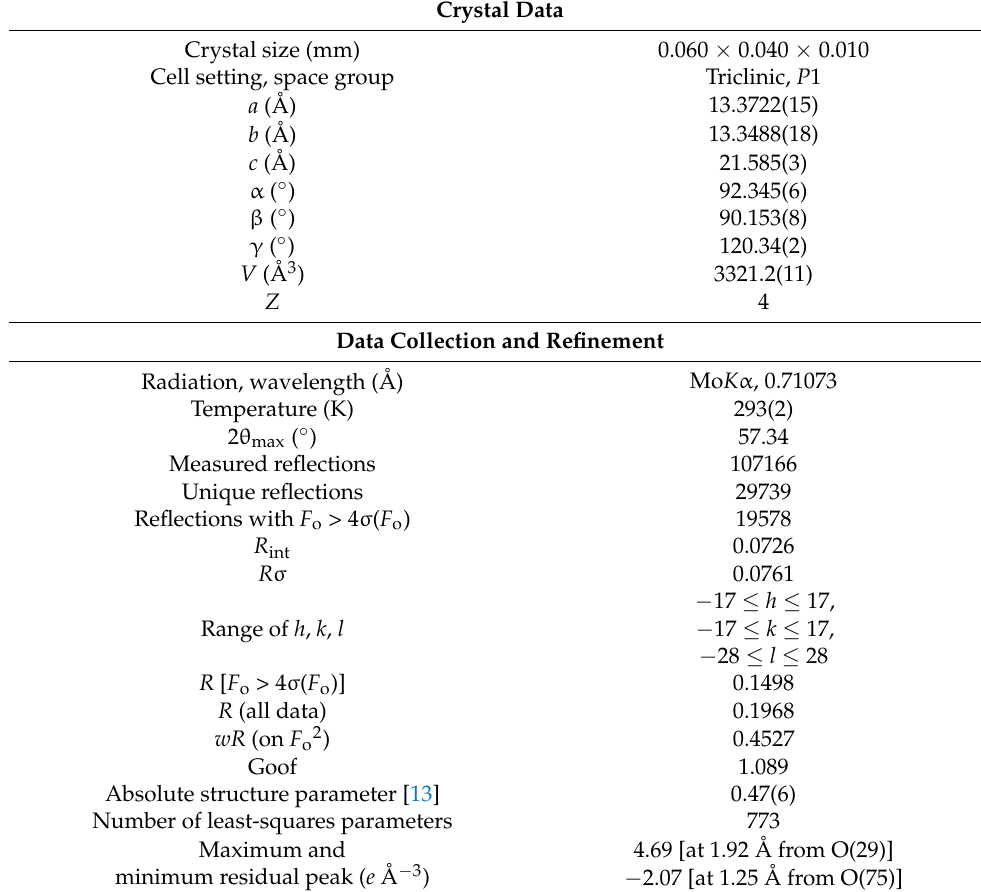
Table 1. Crystal and experimental details for